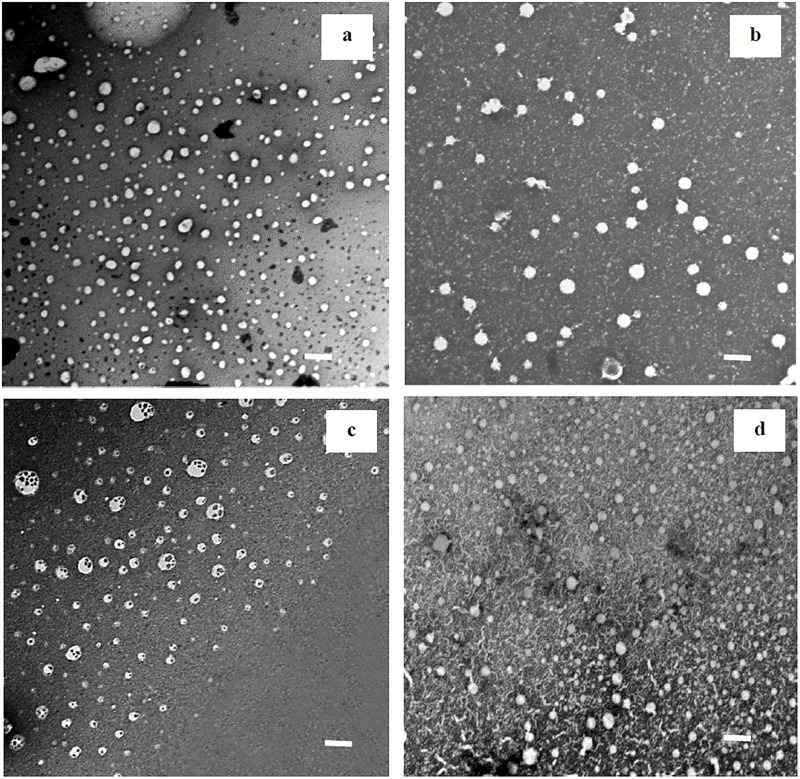
TEM images of miltefosine lipid nanocapsules (MFS-LNCs)..(a) Plain MFS-LNCs, (b) MFS-LNC-CTAB+, (c) MFS-LNC-OA and (d) MFS-LNC-OA-CTAB+ at X 7,500 magnification. The scale bar represents 100nm.